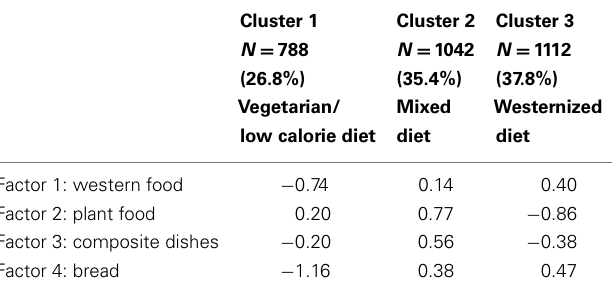
Table 4 | Classification of university students in the study sample by cluster analysis using food categories factor scoring